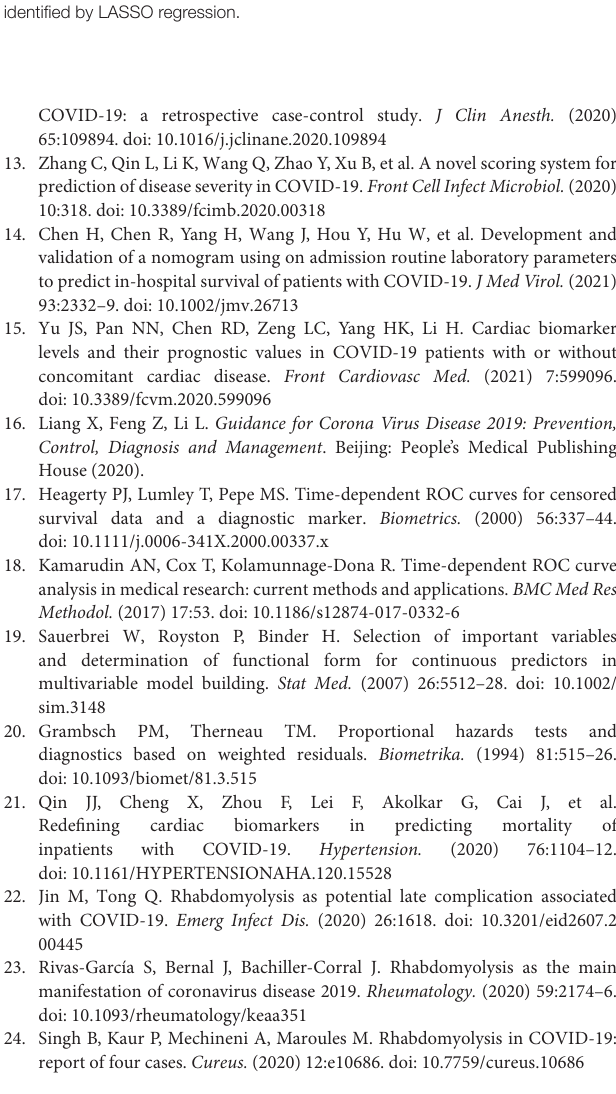
based on the late-stage levels of myocardial biomarkers. ULN, upper limit of normal. Supplementary Figure 4 | Subgroup analysis demonstrating the prognostic ability of MYO in COVID-19 patients without a history of cardiovascular disease. The results showed that MYO provided a better prognostic performance with an independent prognostic effect on in-hospital mortality. (A) Standard ROC curve analysis based on the early-stage levels of biomarkers. (B) Time-dependent AUC curves based on the early levels of cardiac markers. (C) Standard ROC curve analysis based on the late-stage levels of biomarkers. (D-F) LASSO regression and multivariate COX analysis based on early levels of biomarkers. (G-I) LASSO regression and multivariate COX analysis based on late levels of biomarkers. LASSO, least absolute shrinkage and selection operator; MYO, myoglobin; NEU, neutrophil; hs-CRP, high sensitivity C-reactive protein; IL-6, interleukin 6; N , number; AUC, area under curve. Supplementary Table 1 | Laboratory results at the early and late stages in the overall study population, survivors and non-survivors. Supplementary Table 2 | Effects of variables on in-hospital mortality analyzed by univariate Cox proportional-hazards regression. Supplementary Table 3 | Association of elevated myocardial marker levels above ULN with in-hospital mortality of COVID-19. Supplementary Table 4 | Multivariate Cox analysis of prognostic factors identified by LASSO